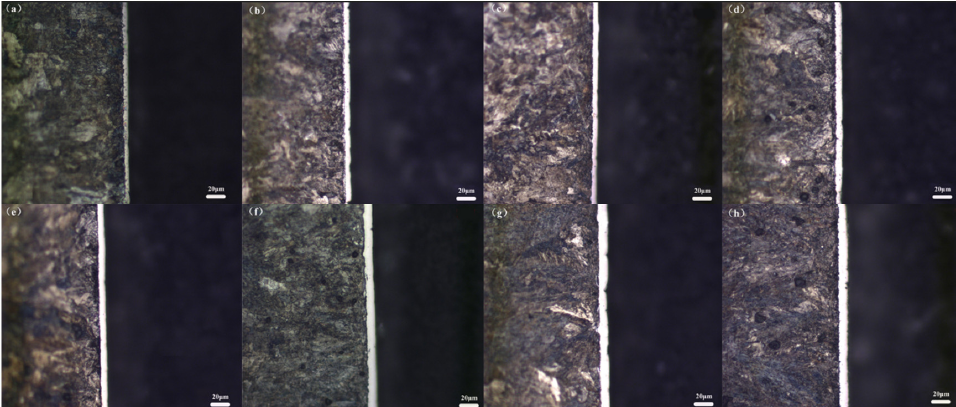
Figure 3. Sectional microstructure of the vanadiumizing layer prepared at different heating temper- atures for 1 h and 7 h. ( a ) 1173 K 1 h; ( b ) 1193 K 1 h; ( c ) 1213 K 1 h; ( d ) 1233 K 1 h; ( e ) 1173 K 7 h; ( f ) 1193 K 7 h; ( g ) 1213 K 7 h; ( h ) 1233 K 7